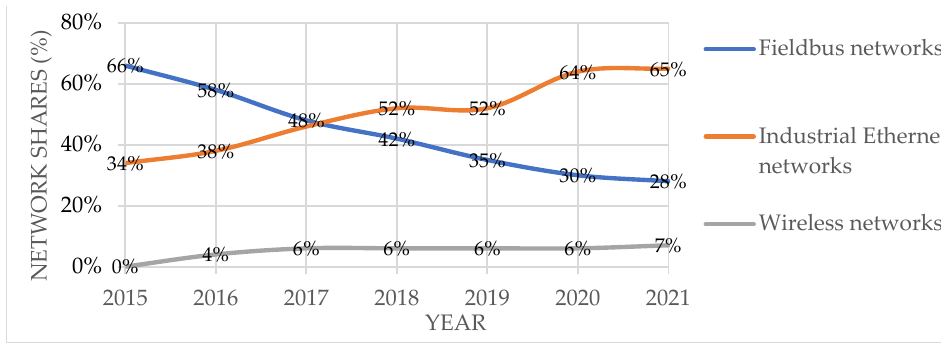
Figure 1 . Industrial networks’ market shares . Figure 1. Industrial networks’ market